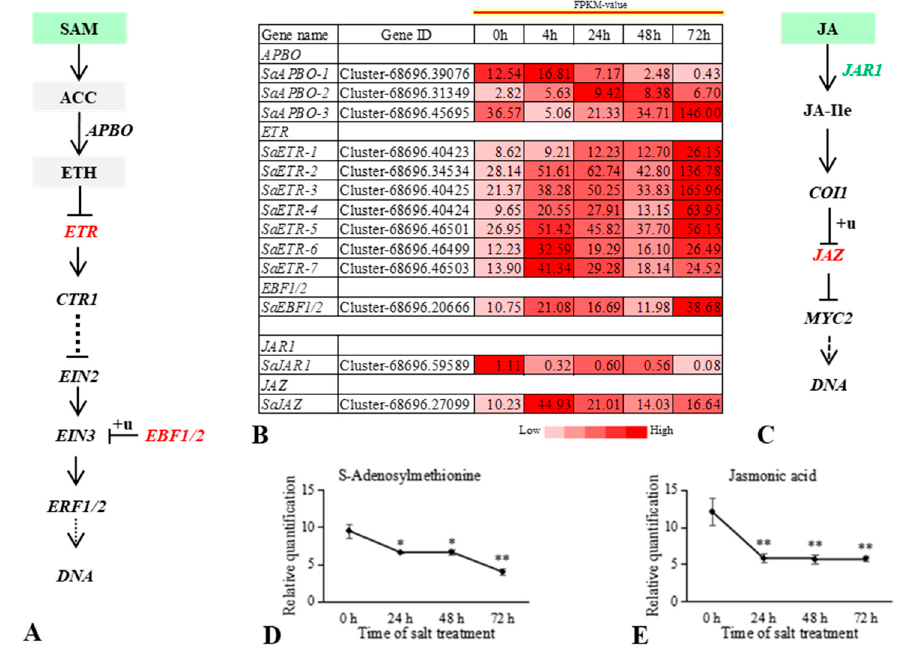
Figure 7. Overview of the relationship between differentially expressed genes (DEGs) and differential metabolites (DMs) in the ETH and JA signaling pathway of Sophora alopecuroides under salt stress. ( A ) Overview of ETH signaling pathway. ( B ) Heat map of ETH and JA signaling pathway-related gene expression. Values are average FPKM value of each sample in each group. ( C ) Overview of JA signaling pathway. ( D , E ) The trend in ETH and JA signaling pathway DM changes with salt stress. The horizontal axis represents the duration of salt treatment, and the vertical axis represents the relative quantification of metabolites (peak area × 10 6 ). Expression levels of six independent samples of metabolites and the control were compared by t -test, where ** represents p < 0.01 and * represents p < 0.05. Expression scores are shown as fold-change. ACC, 1-aminocyclopropane-1- carboxylate; APBO, aminocyclopropanecarboxylate oxidase; EBF1/2, EIN3-binding F-box protein; ERF1, ethylene-responsive transcription factor 1; ETH, ethylene; ETR, ethylene receptor; JA, jas- monate; JAR1, jasmonic acid-amino synthetase; JAZ, jasmonate ZIM domain-containing protein; SAM, S -adenosyl- l